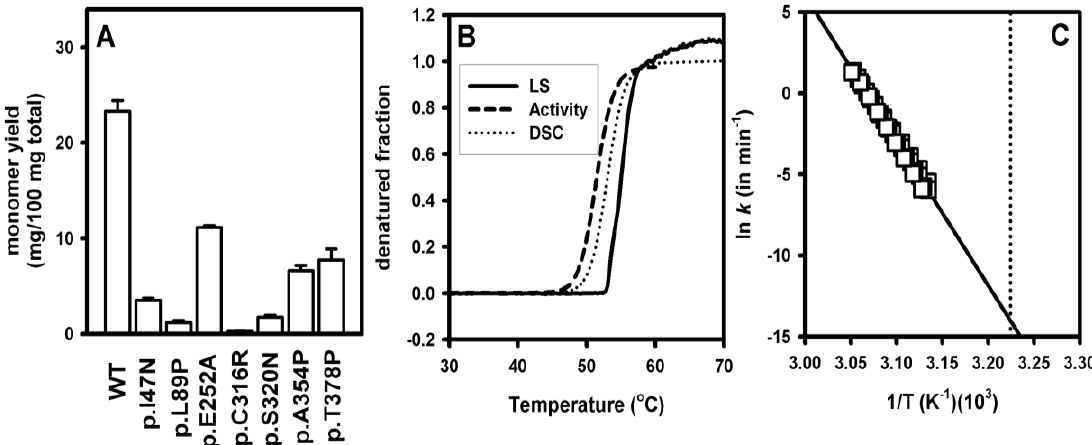
Figure 3. Aggregation of hPGK1 enzymes in vitro and upon expression in E. coli cultures ( A ) Fraction of soluble hPGK1 existing as a monomer upon expression analyses of hPGK1 enzymes in E. coli . The data are means ± s.d. from three independent expression experiments and were obtained starting from the same amount of total soluble protein and upon purification by ion-exchange and size exclusion chromatography as described [13,45] ( B ) Normalized thermal denaturation profiles for WT hPGK1 monitored by activity, light scattering (LS) and differential scanning calorimetry (DSC) measurements; Note that the three techniques provide similar denaturation profiles. ( C ) Arrhenius plots for the thermal denaturation of WT hPGK1 obtained from DSC experiments using a two-state irreversible model [13] and used to determine denaturation rates at 37 °C (indicated by the vertical dotted